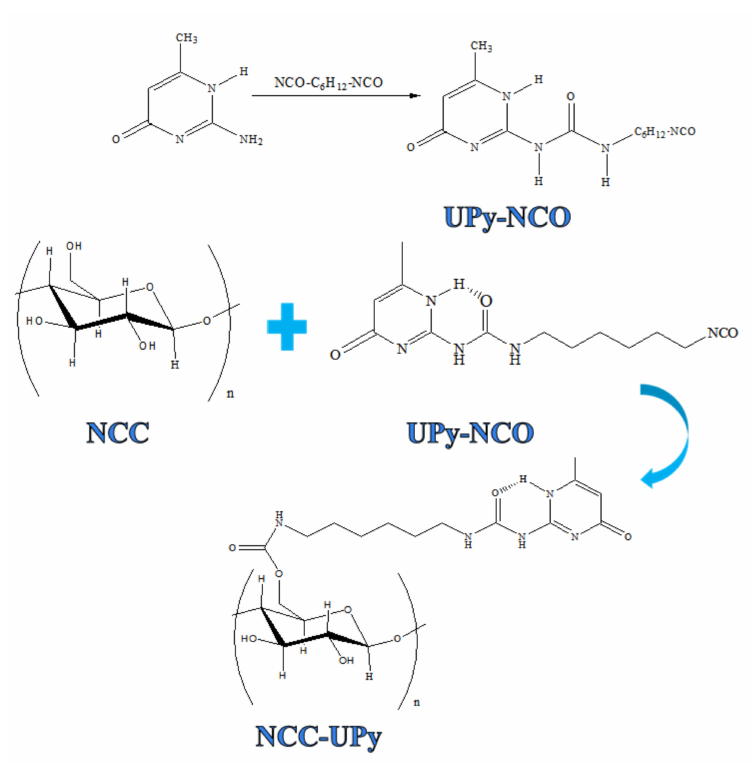
Figure 1. Schematic illustration of the UPy-functionalized